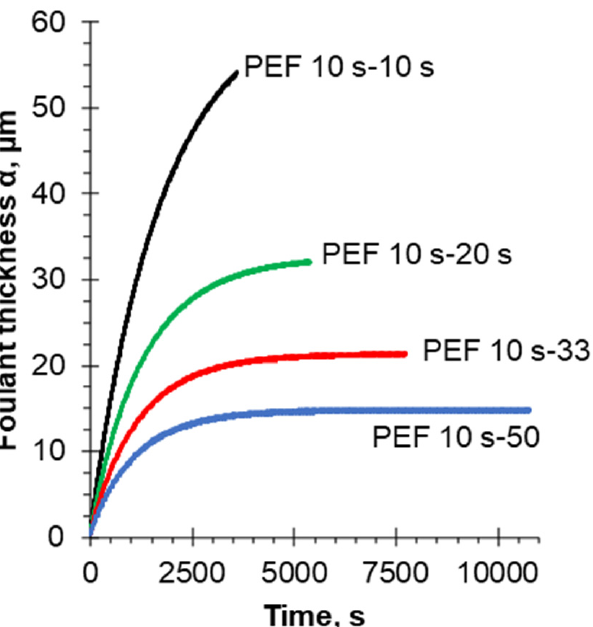
Figure 8. Concentration profiles of the components of the model solution between the surface of the BPM cation-exchange layer (x = 0) and the outer boundary of the DBL (x = 60 µm). Calculations are made for the PEF mode 10 s–33 s in: ( a ) the end of the pulse lapse (7669 s after the current was turned on); ( b ) the end of the pause lapse (7701.7 s after the current was turned on). The steady-state condition and flow rate corresponding to Re = 187 and δ = 60 µm are considered.